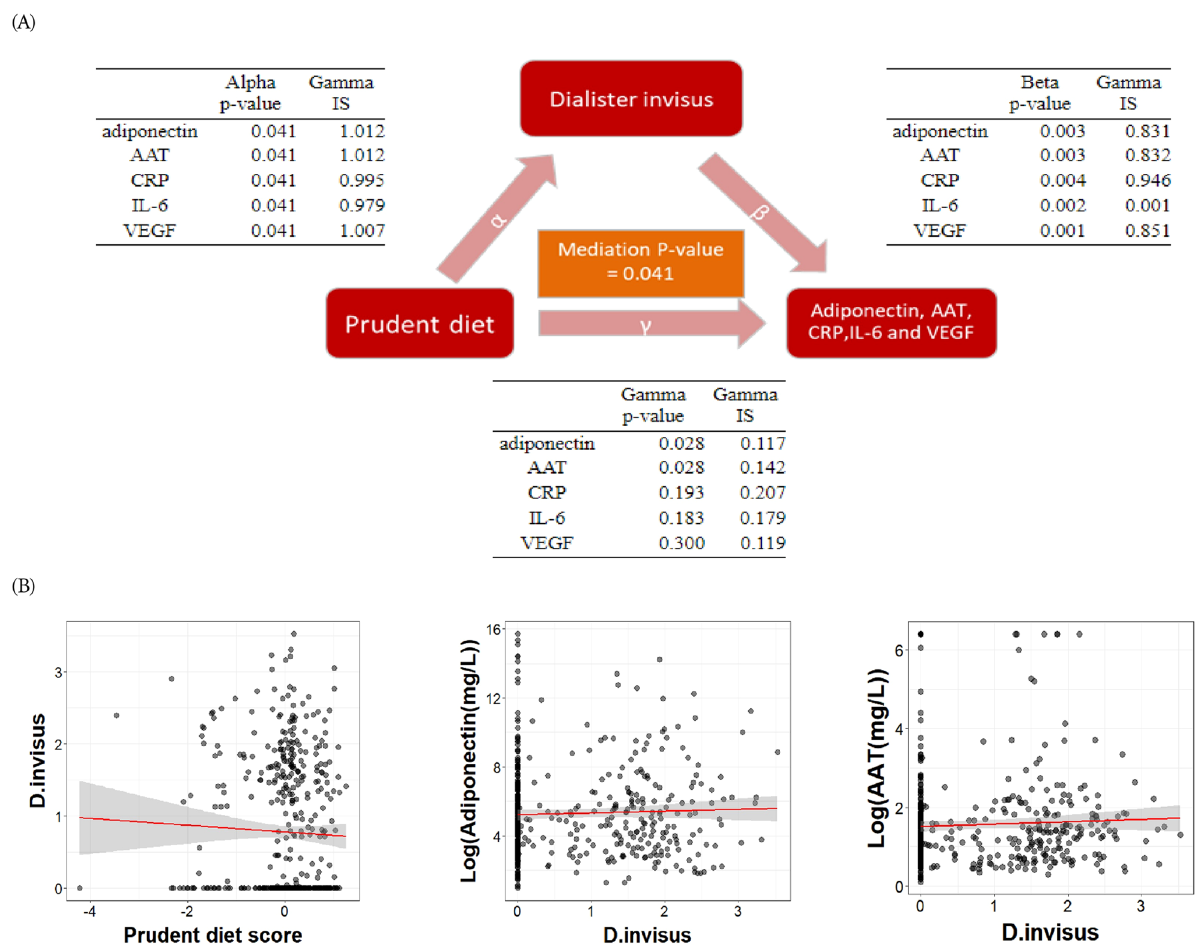
Figure 3. Results of the NPEM method depicted in the mediation framework. ( A ) Dialister invisus mediates the relationship between the prudent diet and diponectin, AAT, CRP, IL-6 and VEGF ( P = 0.041). The alpha, beta and gamma pathways represents the effect of the prudent diet on Dialister invisus , the effect of Dialister invisus on the immune factors, and the effect of the prudent diet on the immune factors, respectively. FDR corrected p-values of the pathways are shown for each immune factor. IF: information score. ( B ) Scatterplots show the relationship between prudent diet on D.invisus and D.invisus on immune markers, the unit is 1 out of